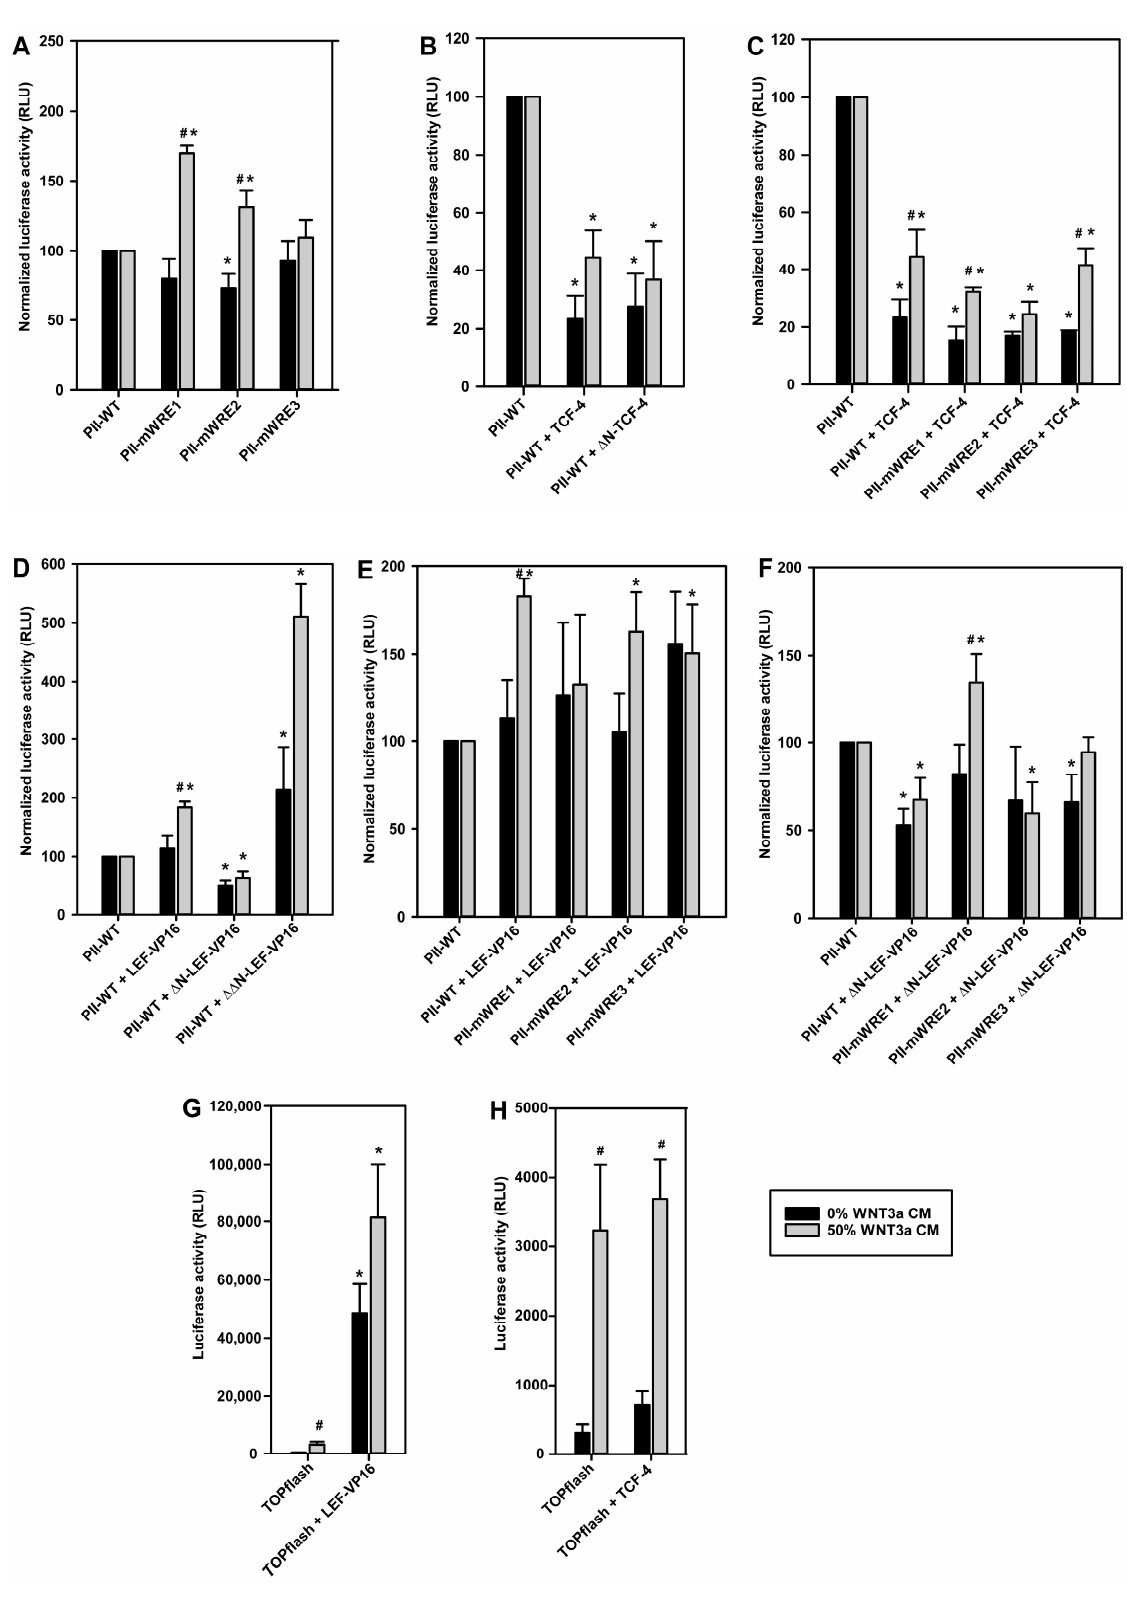
Figure 6. Functional consequences of TCF-4 or LEF-1 binding to WREs in the aromatase promoter I.3/II region. 3T3-L1 preadipocytes were transfected with wildtype aromatase promoter I.3/II reporter constructs pGL3-PII-522 (PII-WT), or derived constructs with inactivating mutations in WRE1 (PII-mWRE1), WRE2 (PII-mWRE2), or WRE3 (PII-mWRE3). Alternatively, the TOPflash